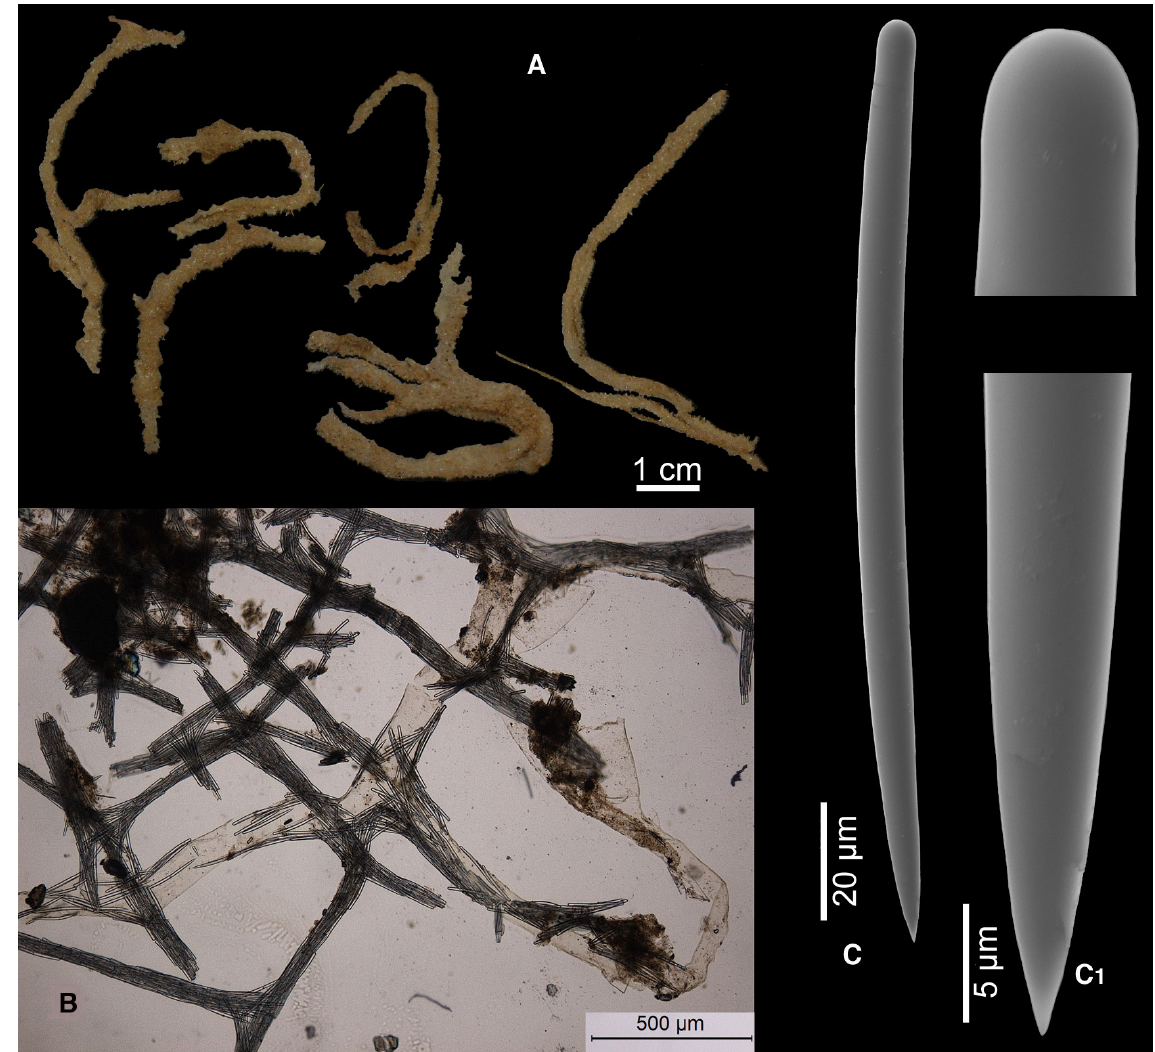
Fig. 7. Ulosa stuposa (Esper, 1794), ZMA Por. 06766. A . Fragmented habit. B . Cross section of skeleton. . Detail of C . SEM image of style. C 1